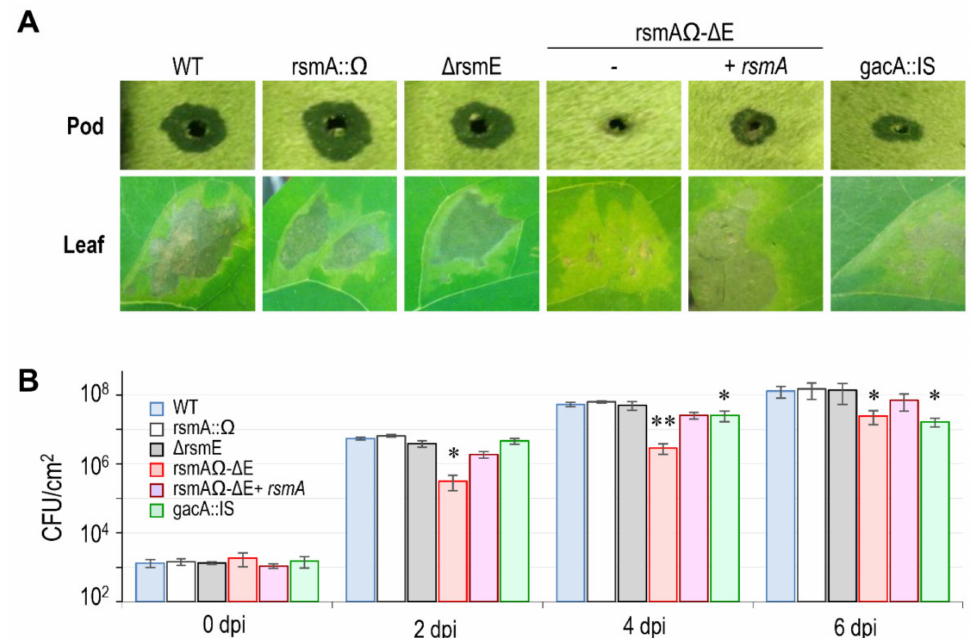
Figure 4. Genes rsmA and rsmE redundantly control virulence in bean ( Phaseolus vulgaris ). ( A ) Representative symptoms induced by P. amygdali pv. phaseolicola 1448A (WT) and derivative mutants in pods and leaves of bean cv. Canadian Wonder at 6 days post-inoculation. ( B ) Growth course of WT and mutant strains in leaves of bean cv. Canadian Wonder, after inoculation with suspensions of 10 6 cfu mL − 1 . *; significant di ff erences to WT, **; significant di ff erences to WT and the gacA mutant, as determined by an ANOVA ( p < 0.05). Error bars correspond to the standard deviation of three biological replicates, each with three technical replicates. Similar results were obtained for strain rsmA Ω - ∆ E complemented with rsmA or with rsmE